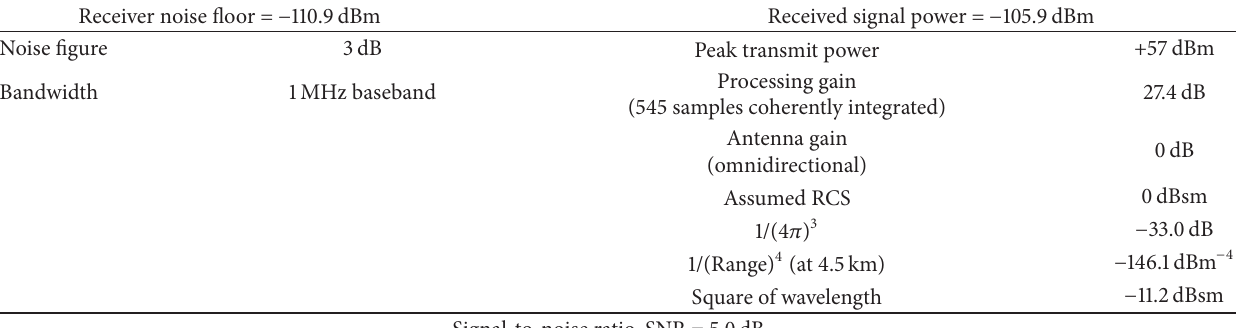
Table 2: Link budget